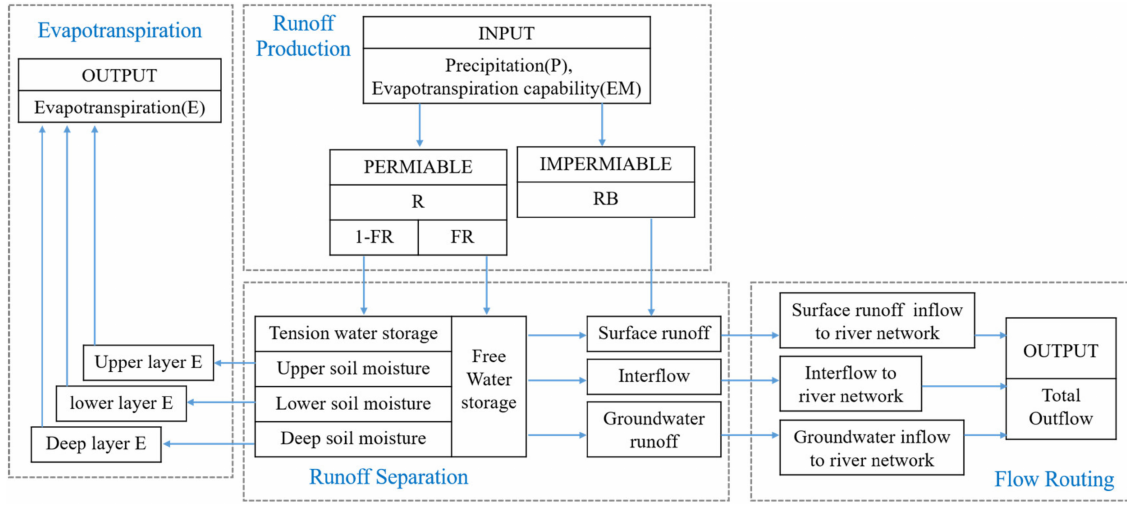
Figure 1. Flowchart of the XAJ